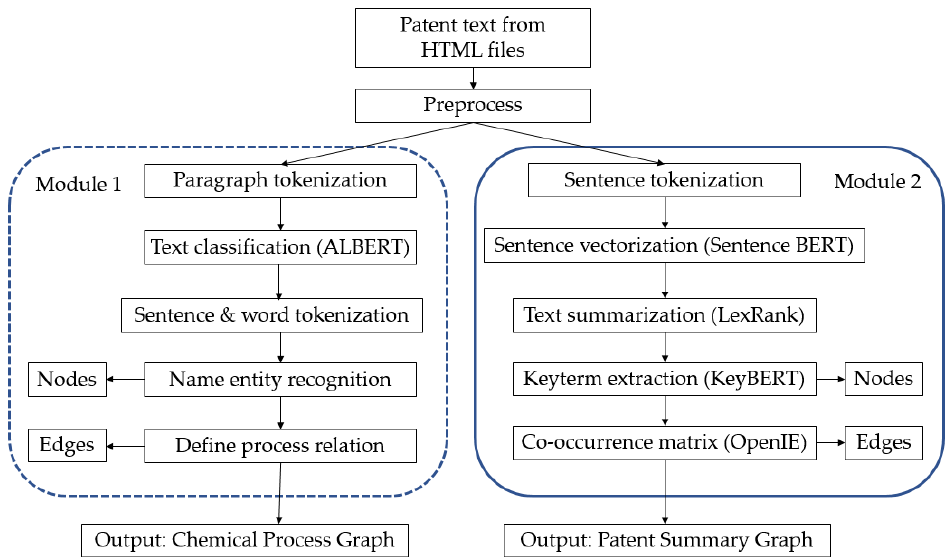
Figure 2. The system architecture shows the parallel modules of chemical process and patent sum- mary graphs.